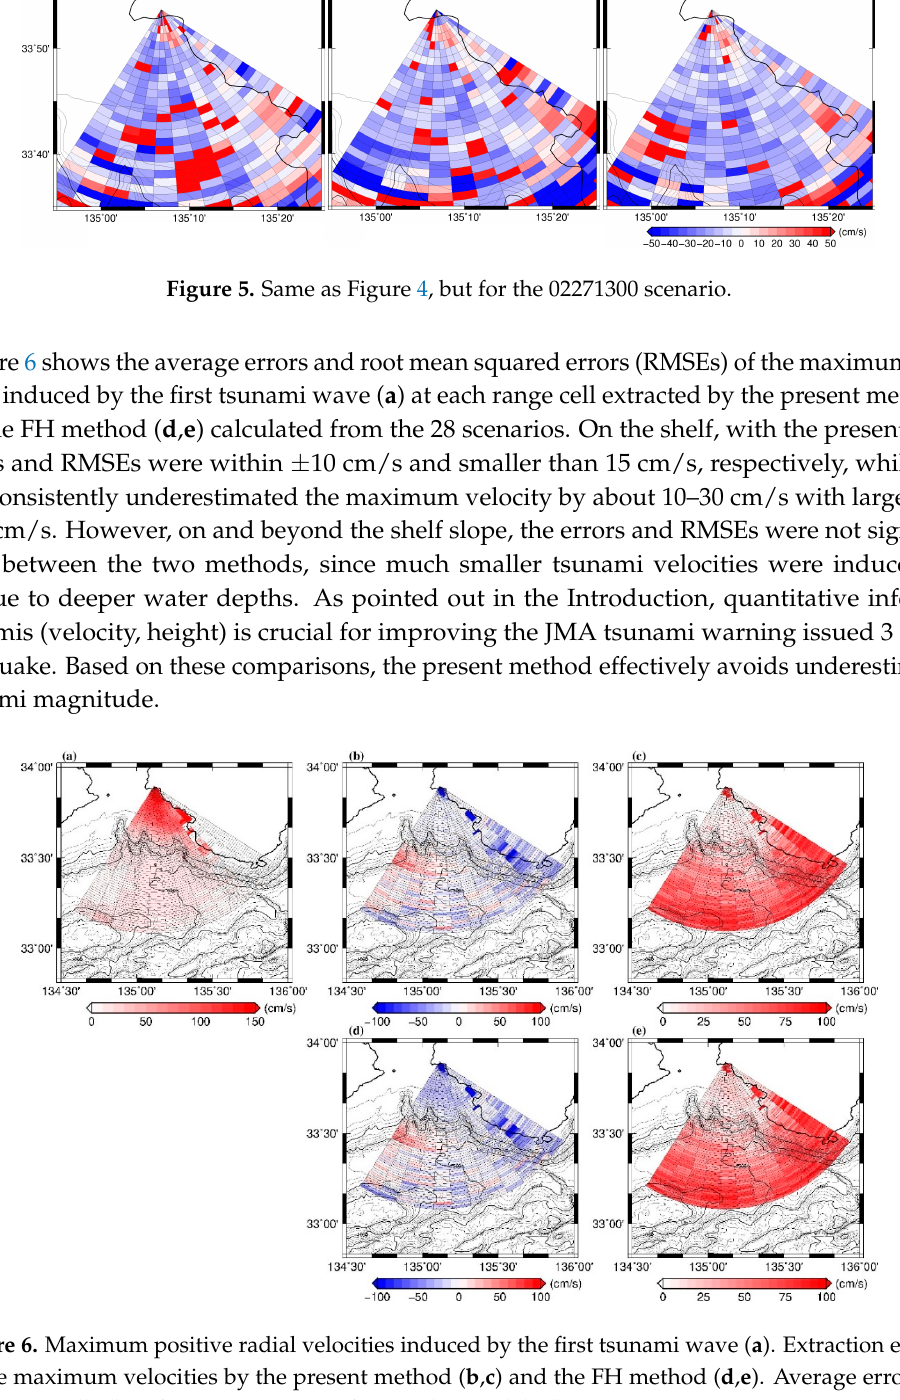
Figure 6. Maximum positive radial velocities induced by the first tsunami wave ( a ). Extraction errors of the maximum velocities by the present method ( b , c ) and the FH method ( d , e ). Average errors of 28 scenarios ( b , d ) and root mean squared errors (RMSEs) ( c , d ).